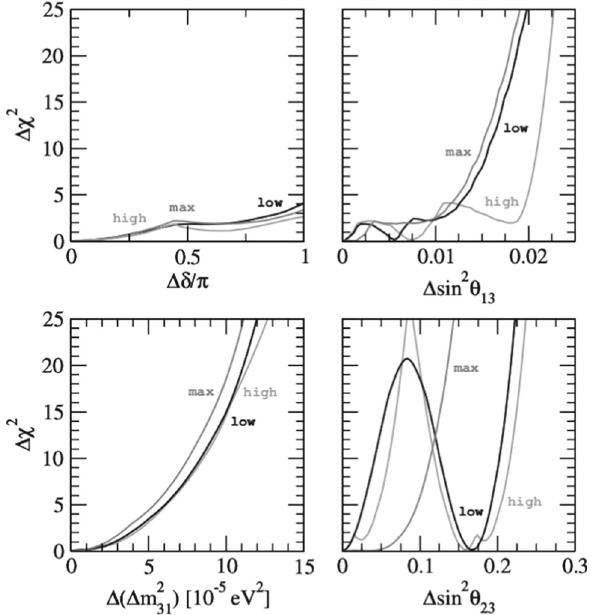
Fig. 10 The sensitivities of DUNE to the difference of neutrino and antineutrino parameters: Δδ , Δ(Δ m 2 for the atmospheric angle in the lower octant (black line), in the upper octant (light gray line) and for maximal mixing (dark gray